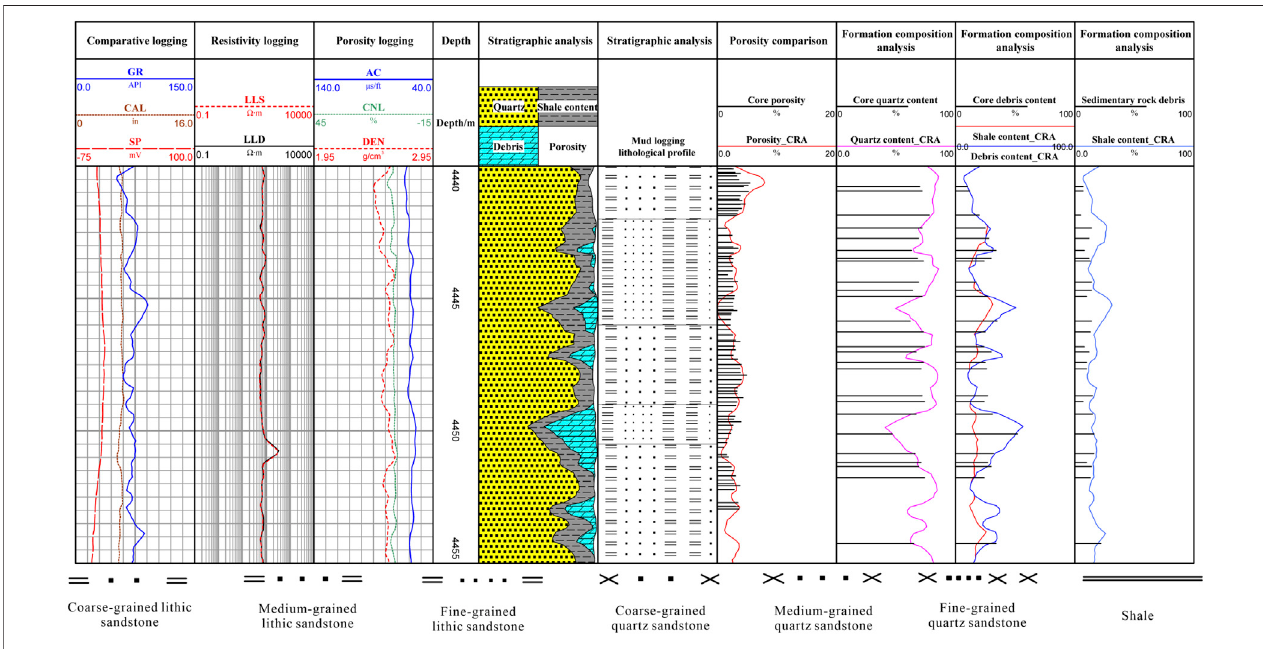
FIGURE 7 | Comparison of the lithological pro fi le and formation composition of 4,440 – 4,455 m in well 1.